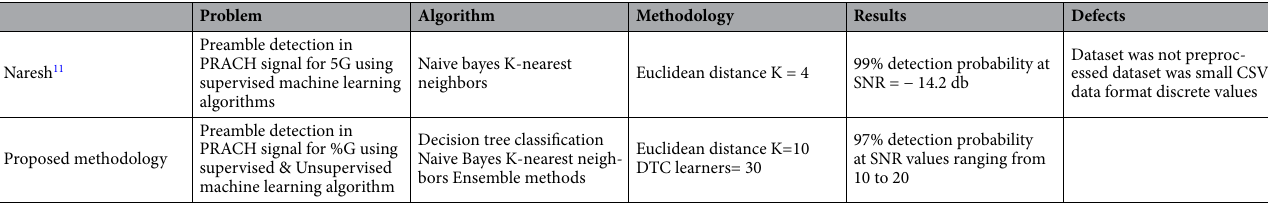
Table 5. Comparison of proposed methodology with benchmark